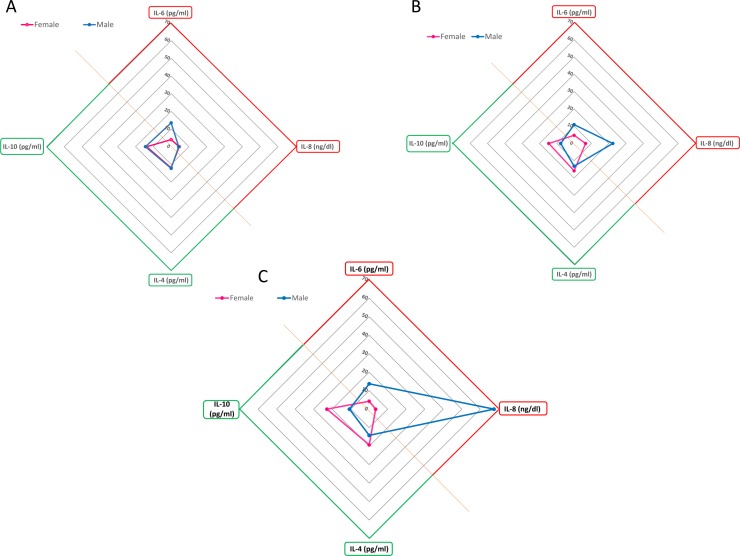
Use of multi-cytokine sensors analyse the balance between pro- and anti-inflammatory cytokine release following cortisol challenges.A) pro-/anti-inflammatory balance in non-stimulated PBMCs; B) pro-/anti-inflammatory balance in physiological cortisol-stimulated PBMCs; C) pro-/anti-inflammatory balance in high cortisol-stimulated PBMCs. Pro-inflammatory interleukins are represented in red; anti-inflammatory interleukins are represented in green. The orange line represents the border between the anti- (under) and pro- (above) inflammatory secretion areas.